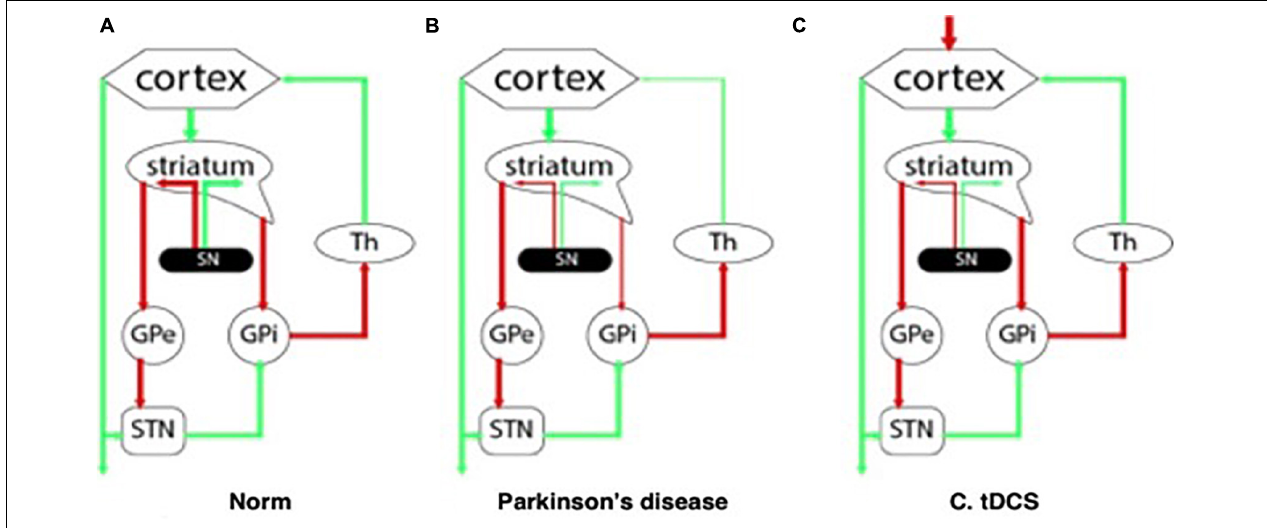
FIGURE 1 | Interaction between the structures of the central nervous system: (A) at normal; (B) with Parkinson’s disease; (C) in the pathogenetic therapy of Parkinson’s disease using